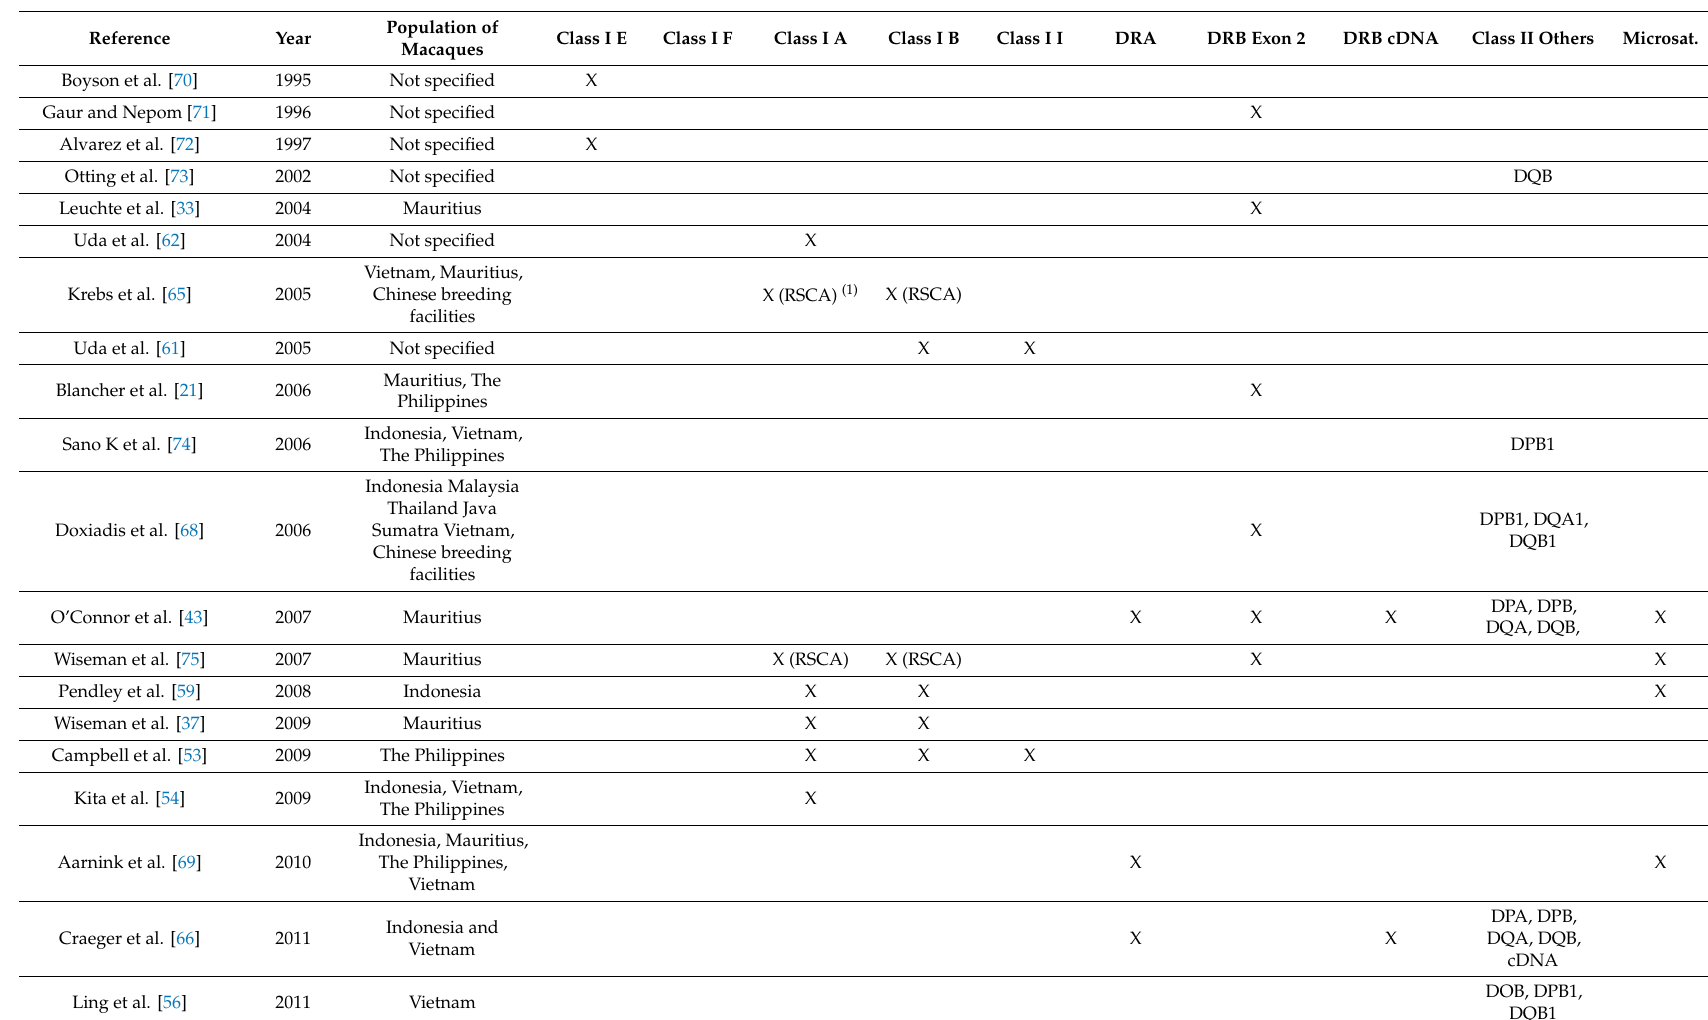
Table 2. Cynomolgus macaque MHC polymorphism in various